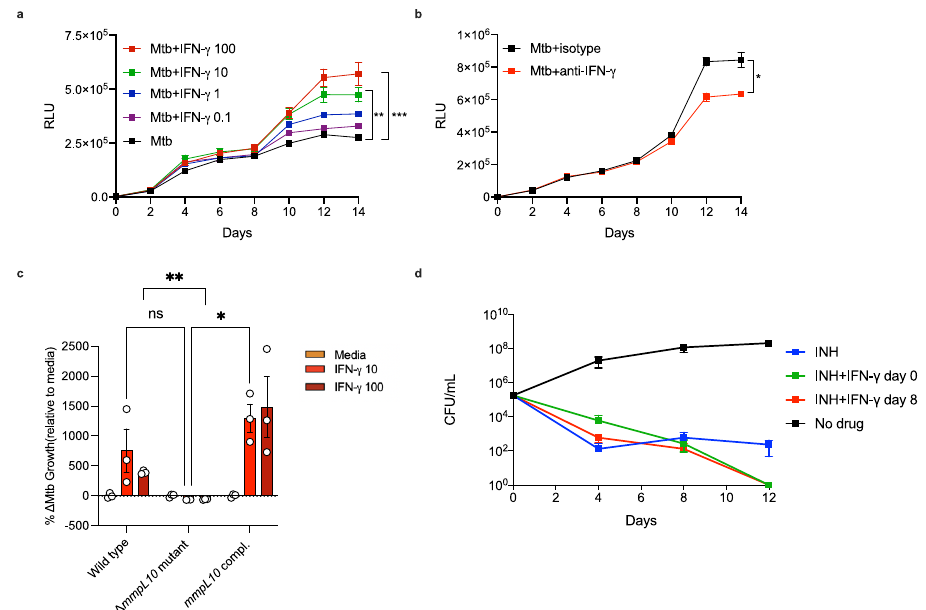
Fig. 6 IFN- γ promotes Mtb growth via MmpL10. Mtb-infected human PBMCs were encapsulated in 3D microspheres. IFN- γ increases bacterial growth ( a ) measured by relative light units (RLU) in a dose-dependent manner at the concentrations (ng/mL) indicated. In accordance, blockade of IFN- γ reduces bacterial growth ( b ). The effect of IFN- γ at the concentrations indicated (ng/mL) on bacterial growth compared between wildtype Mtb , Δ mmpl10 mutant and mmpl10 -complement in 3D microspheres, showing no effect of IFN- γ on the Δ mmpl10 mutant strain ( c ). IFN- γ stimulation enhances INH-mediated killing of Mtb ( d ). Data is shown as ± SEM of n = 3 technical replicates and represent at a minimum two independent experiments. CFU data is shown as the percentage of bacterial growth in media containing IFN- γ compared to media. Tukey ’ s correction multiple-comparison test and Mann – Whitney test was used for the statistical analysis. ns = not signi fi cant * p < 0.05, ** p < 0.01, *** p <